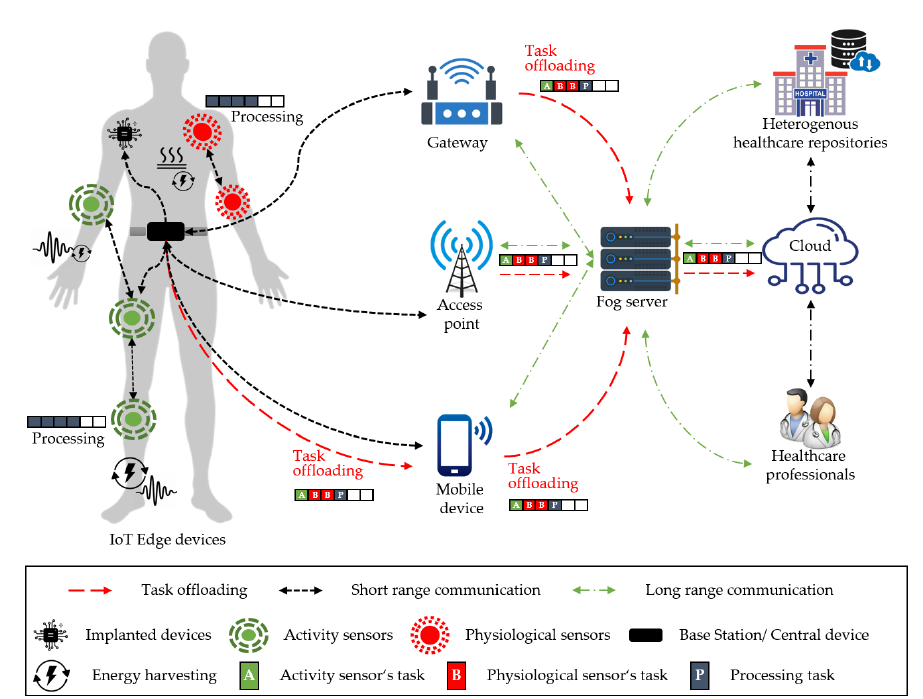
Figure 2. General architecture of an IoMT system based on energy harvesting and with consideration of task